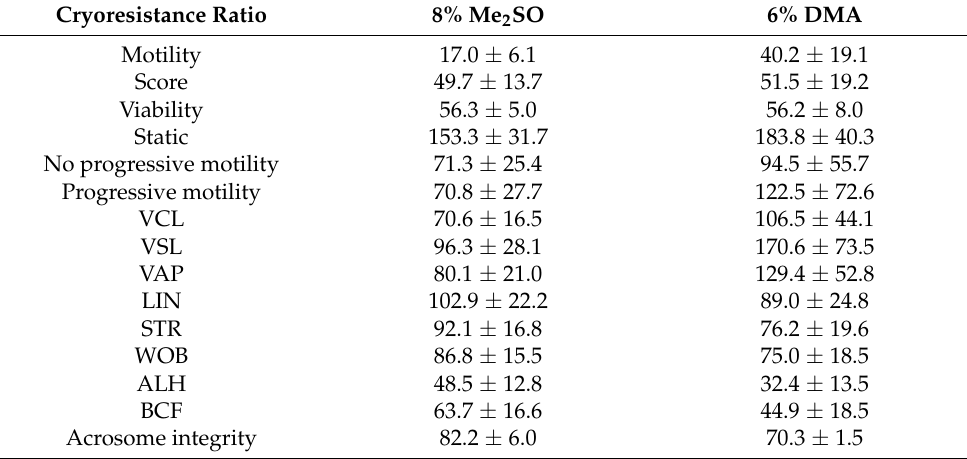
Table 3. Cryoresistance ratio of American flamingo sperm variables frozen with two cryoprotectant agents (8% Me 2 SO and 6%